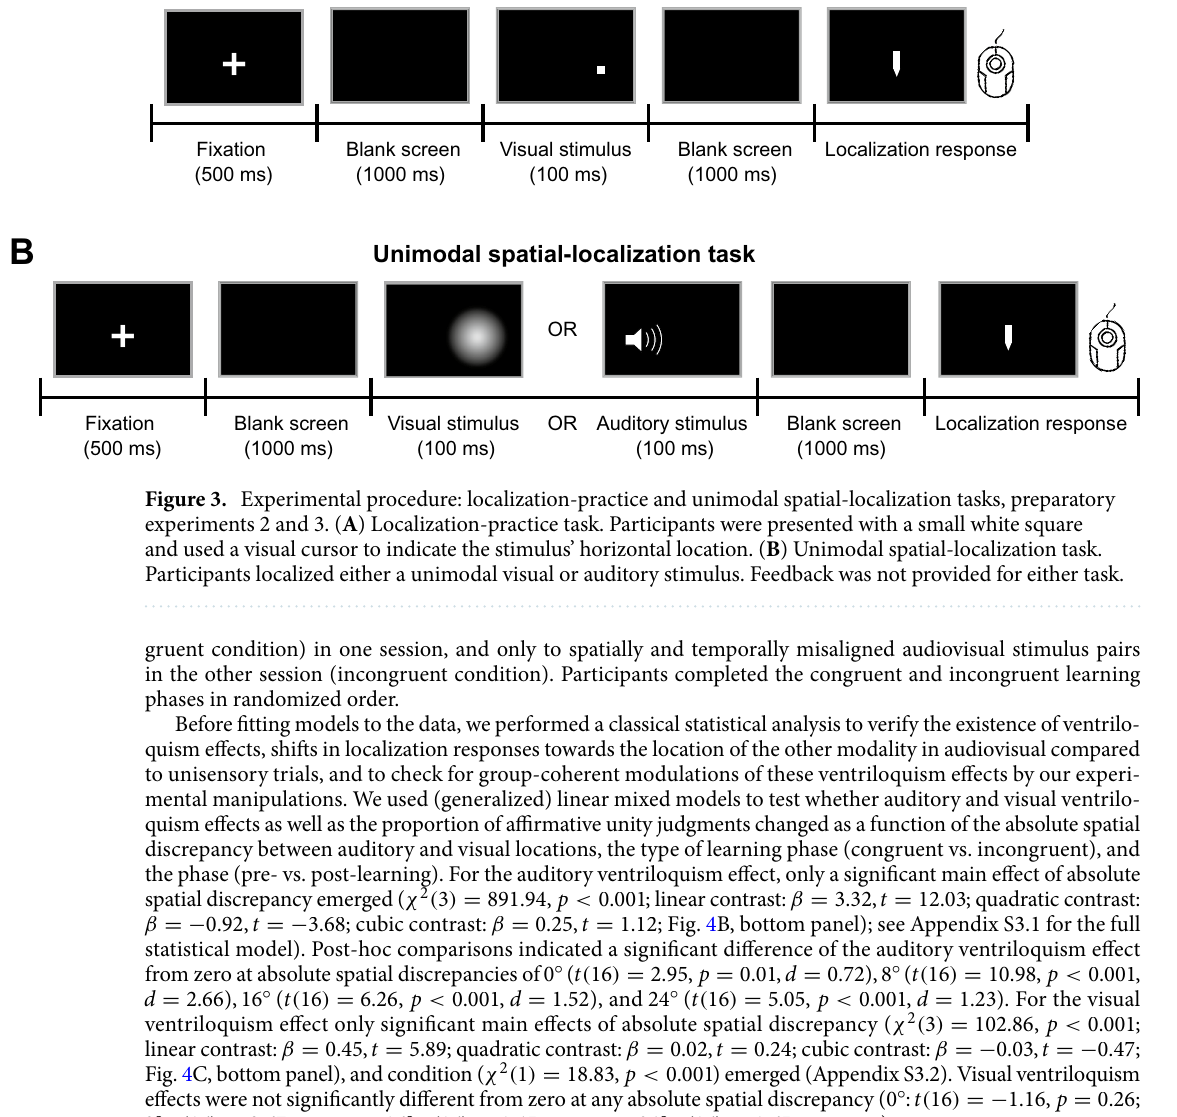
linear contrast: β = 0.45 , t = 5.89 ; quadratic contrast: β = 0.02 , t = 0.24 ; cubic contrast: β = − 0.03 , t = − 0.47 ; Fig. 4C, bottom panel), and condition ( χ 2 ( 1 ) = 18.83 , p < 0.001 ) emerged (Appendix S3.2). Visual ventriloquism ◦ effects were not significantly different from zero at any absolute spatial discrepancy ( 0 : t ( 16 ) = − 1.16 , p = 0.26 ; 8 ◦ : t ( 16 ) = 0.67 , p = 0.51 ; 16 ◦ : t ( 16 ) = 1.45 , p = 0.17 ; 24 ◦ : t ( 16 ) = 1.65 , p = 0.12 ). For the binary unity judgments, only significant main effects of absolute spatial discrepancy ( χ 2 ( 3 ) = 4428.39 , p < 0.001 ; linear contrast: β = − 2.90 , z = − 31.43 , p < 0.001 ; quadratic contrast: β = 0.17 , z = 2.20 , p = 0.03 ; cubic contrast: β = 0.16 , z = 2.57 , p = 0.01 ), and condition ( χ 2 ( 1 ) = 14.56 , p < 0.001 ; β = 0.16 , z = 2.53 , p = 0.01 ) emerged (Fig. 4D, bottom panel; Appendix S3.3).